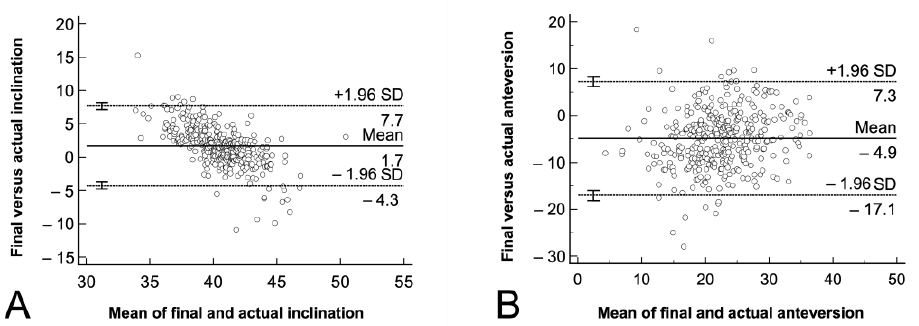
Figure 5. ( A , B ) The Bland-Altman analysis for the accuracy of image-free navigated cup orientation is shown for ( A ) inclination and ( B ) anteversion. The graphical interpretation shows that the measurement pairs were spread evenly and randomly for both angles. The diagram plots the difference between the final intraoperative and the postoperatively determined actual cup orientation against their averages. The mean accuracy (straight line) and the 95% confidence intervals (dotted line) are shown.